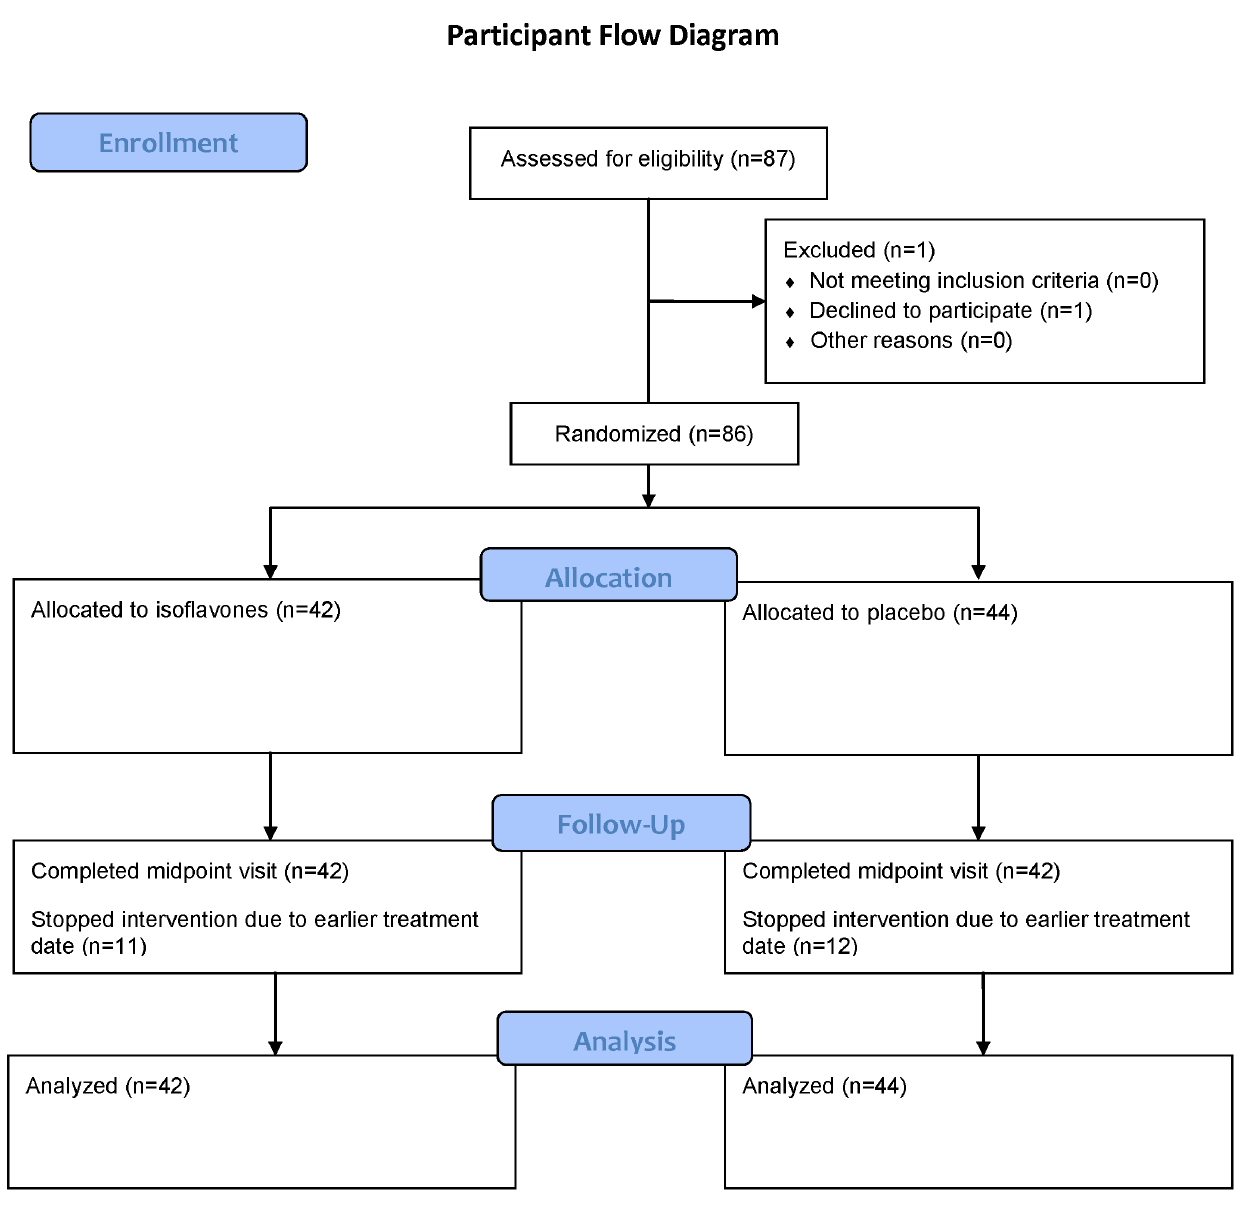
Figure 1. Participant Flow Diagram.